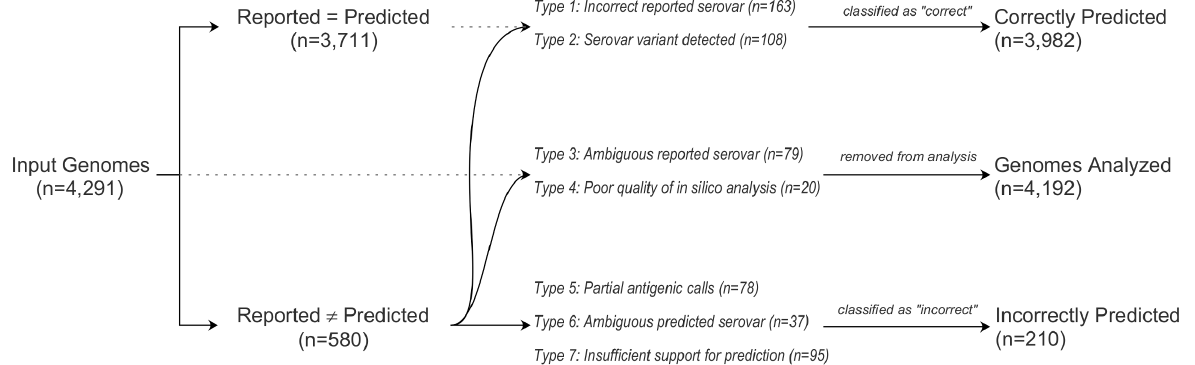
Fig 1. Analysis of sources of error in serovar predictions on a set of 4,291 Salmonella enterica draft genome sequences analyzed using the SISTR platform. The contribution of various types of errors contributing to observed differences between “ reported ” and “ predicted ” serovars was tabulated. From a total of 4,192 genomes retained for the analysis, 3,982 genomes had correct serovar predictions (94.99%).